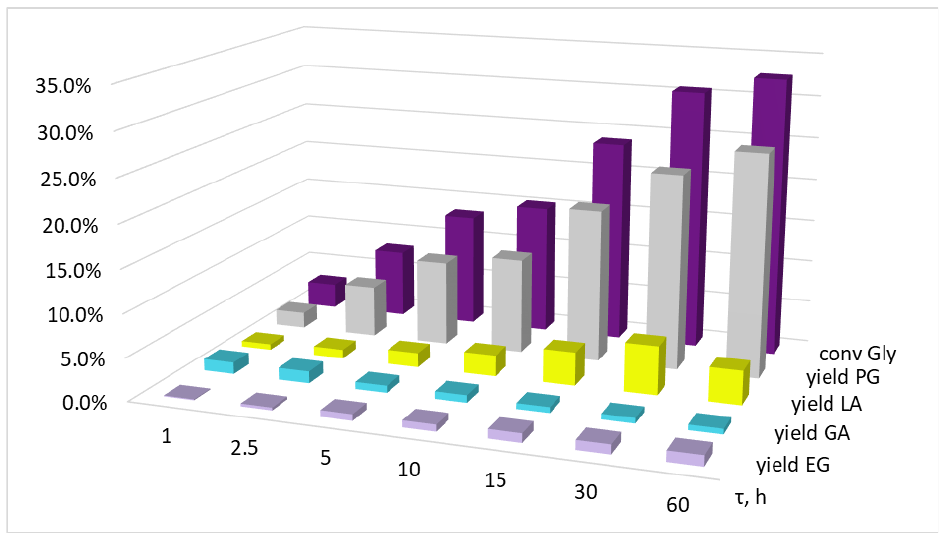
Figure 6. The influence of the reaction time on glycerol conversion and the yields of the products. Conditions: T = 220 °C, p(H 2 ) = 3.0 MPa, KOH/Cu = 2.3 mol, Gly/Cu = 50 mol, Gly/H 2 O = 4.1 vol, precursor salt = Cu(OAc) 2 .